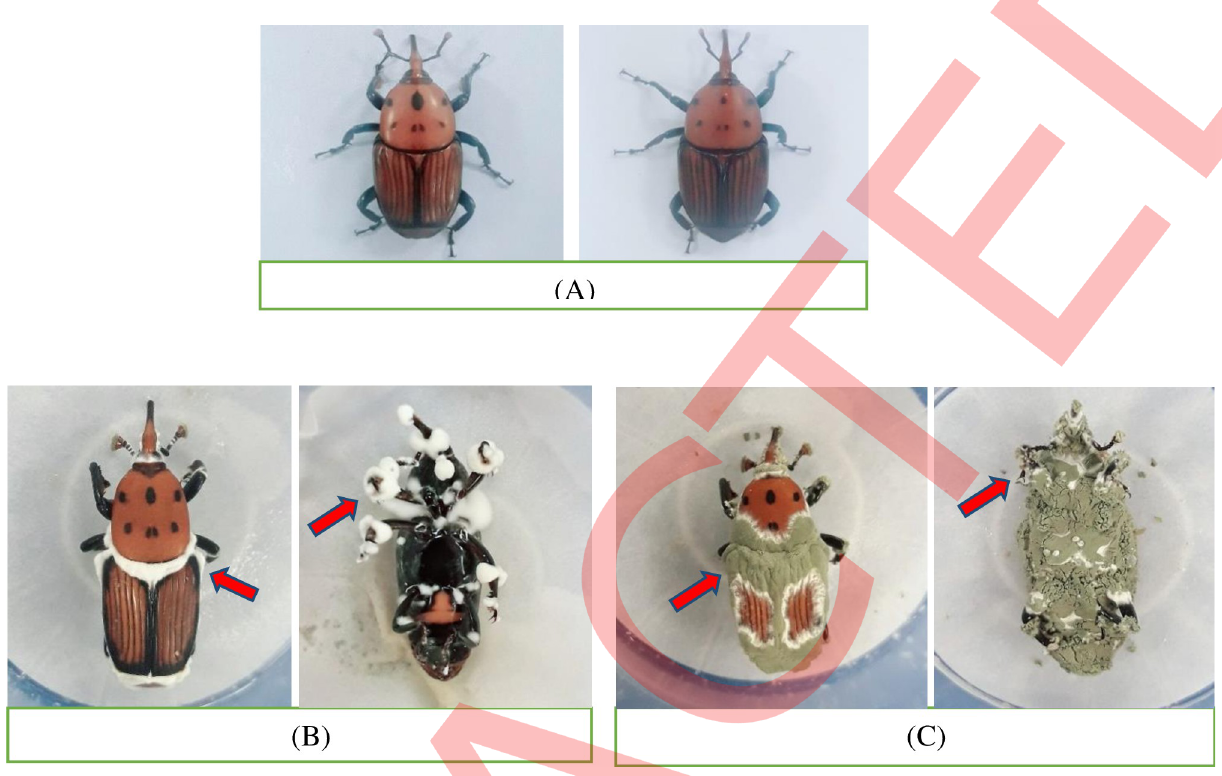
Fig 4. Comparison of healthy and fungi-treated red palm weevil adults. Healthy adults exposed to distilled water (control) (A), and infected adults, exposed to fungi Beauveria bassiana (B) and Metarhizium anisopliae (C).